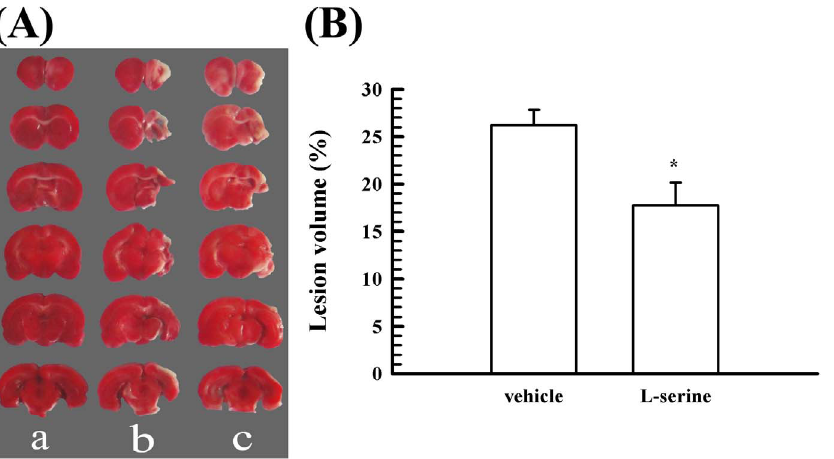
Figure 1. Effect of L-serine treatment on the lesion volume 35 days after pMCAO. (A) Representative examples of TTC staining after different treatments: a, sham-operated group; b, control group; c, L-serine (168 mg/kg) treated group. (B) Mean values of the lesion volume after different treatments (n=5). * p , 0.05 vs . vehicle group. anti-vWF antibody (1:400) at 4 u C overnight and subsequently with secondary antibody FITC-conjugated Affinipure donkey anti- mouse IgG (1:500) or FITC-conjugated goat anti-rabbit IgG (1:1000) at room temperature for 2 h. The sections were covered with coverslips for microscope observation after antibody incuba-